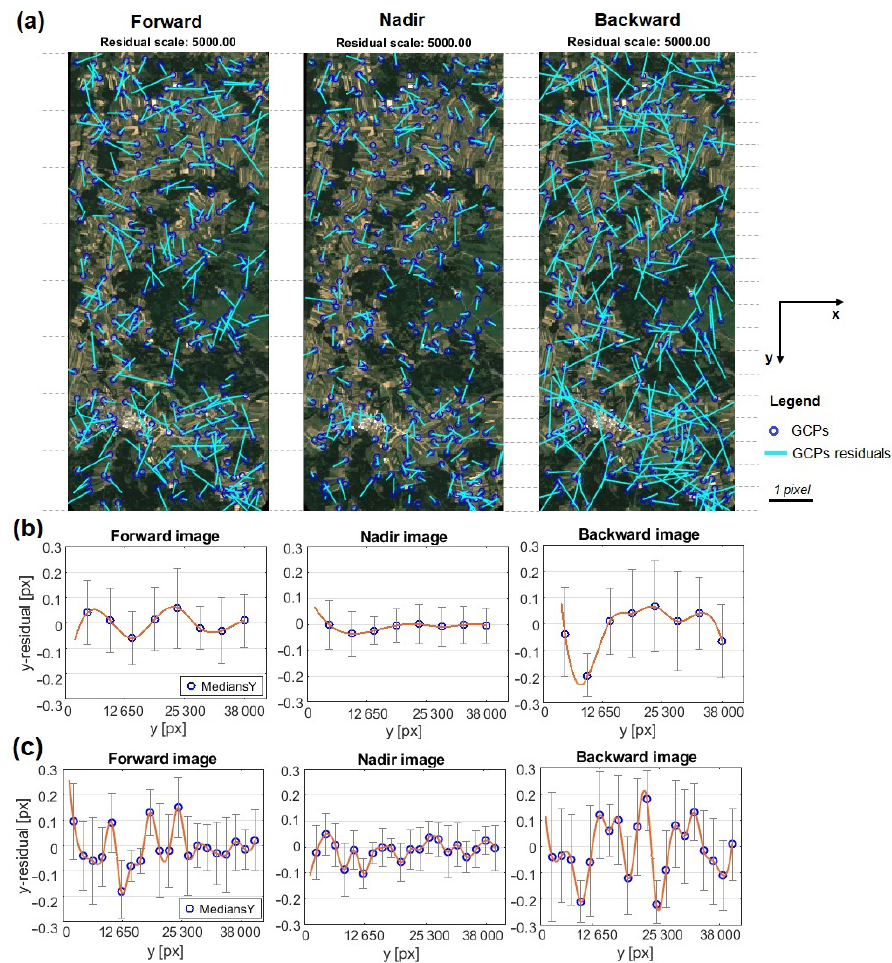
Figure 10. Image re-projection errors of the 300 GCPs in the Allentsteig dataset based on bias- corrected RPC orientation: ( a ) Overview of scaled image residuals in Forward, Nadir and Backward images with marked 8 and 20 section divisions in the flight direction. The vectors were exaggerated 5000 times to enable better illustration. ( b ) Median of y residuals with corresponding robust standard deviations for 8 along-track intervals. ( c ) Median of y residuals with corresponding robust standard deviations for 20 along-track